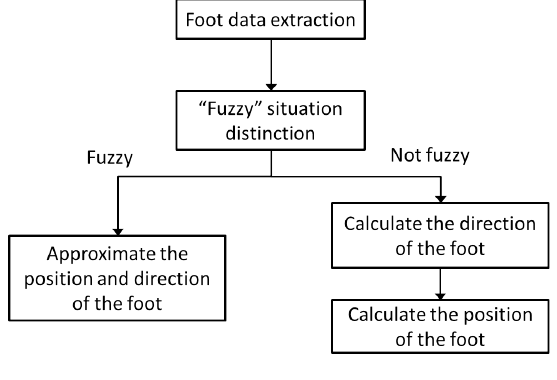
Fig. 7. Procedures of Foot Detection